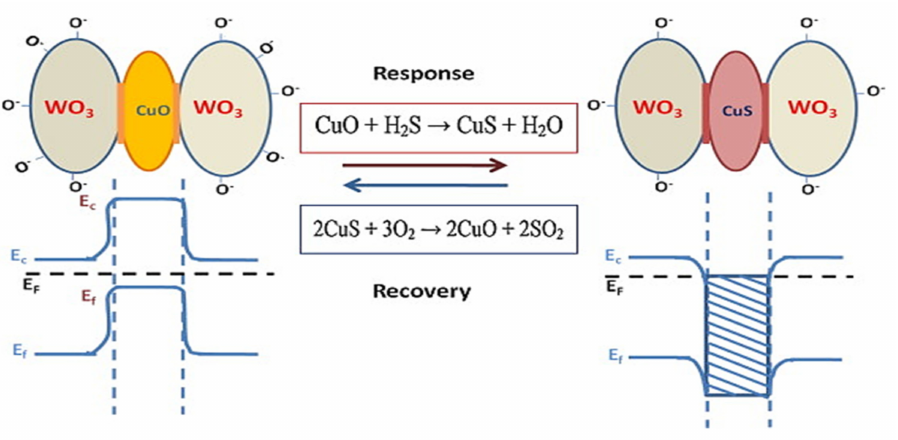
Figure 10. Schematic of the H 2 S-sensing mechanism in CuO/WO 3 heterojunctions. Reprinted from [87] with permission from Elsevier.